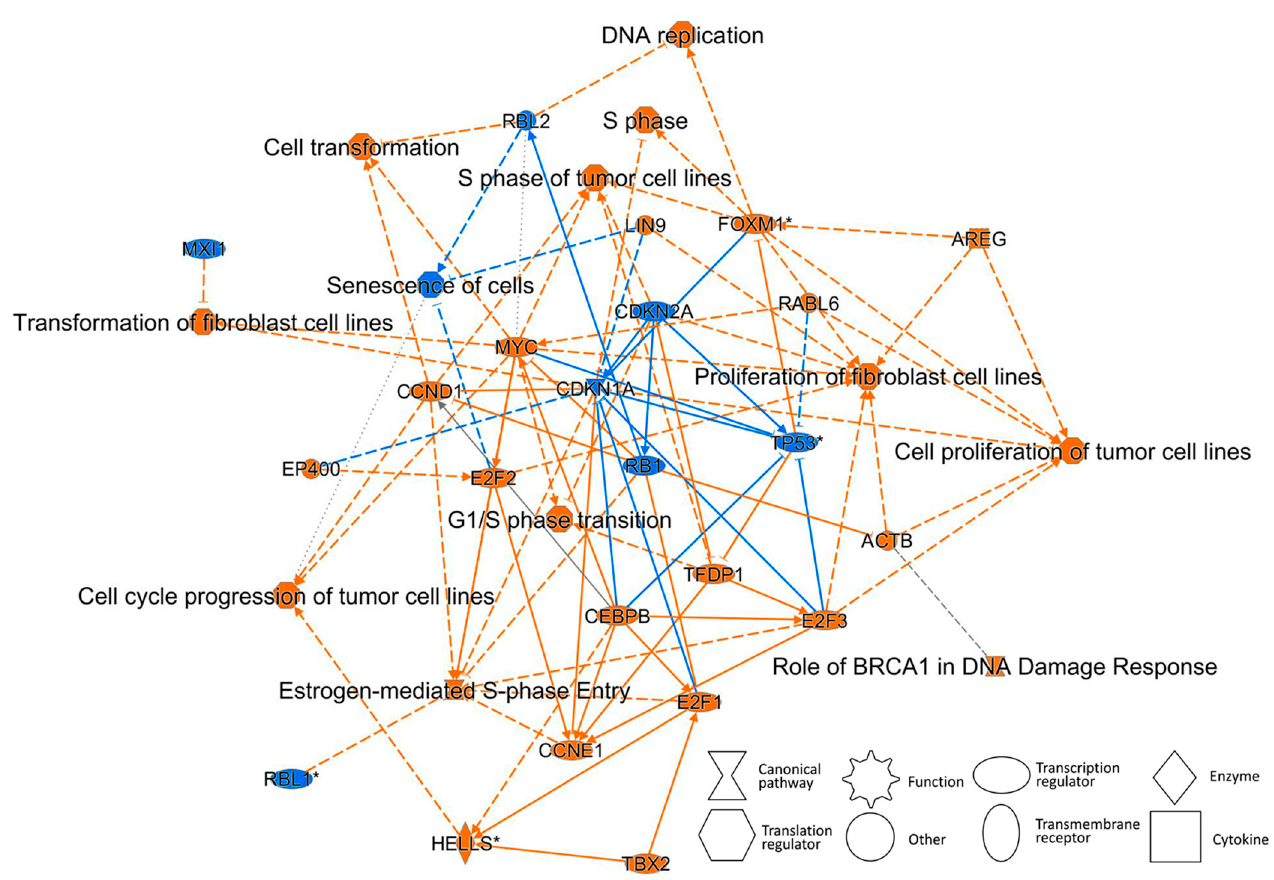
Figure 8. Graphical summary of the molecule and its function following treatment with TPA for 24 h. Graphical summary was analyzed using IPA software. The activated molecule or function has a positive z-score and is therefore orange. The suppressed molecule or function has a negative z-score and is therefore blue. Estimated edges are shown as dotted lines (not solid lines).